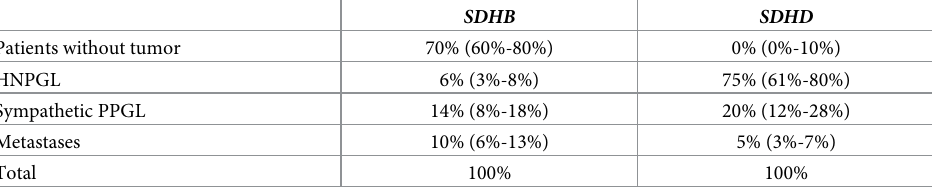
Table 1. Estimated percentages at different clinically-defined steady states in SDHB and SDHD -related PPGL. SDHB SDHD Patients without